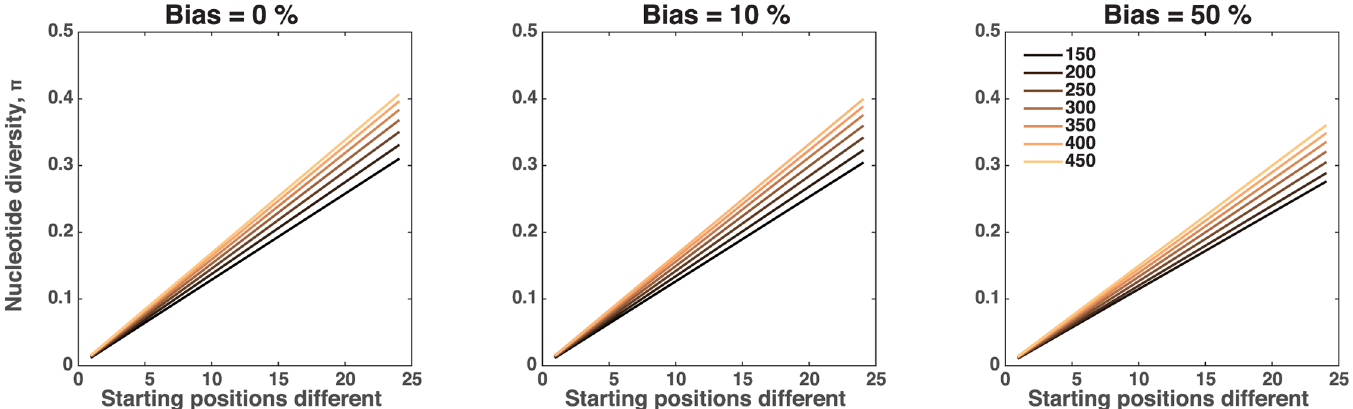
Fig 7. Nucleotide diversity of ruptured oocysts. Nucleotidediversity, π , by differing number of starting positionsbetweengeneticallydistinct parasite populations. Left to right the columnsillustrate the results for 0%, 10% and 50% fitness biases, respectively.Colors refer to the initial gametocyte number with darker colors representinglower gametocyte